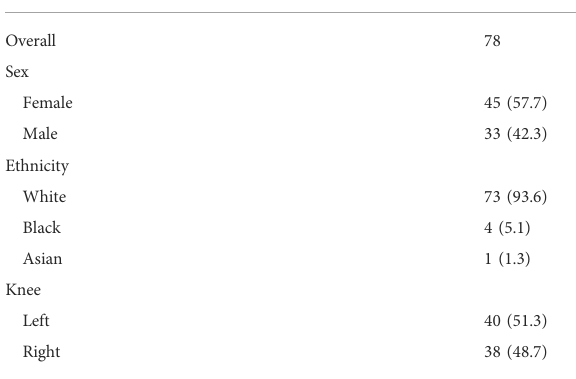
TABLE 1 Test subject demographical